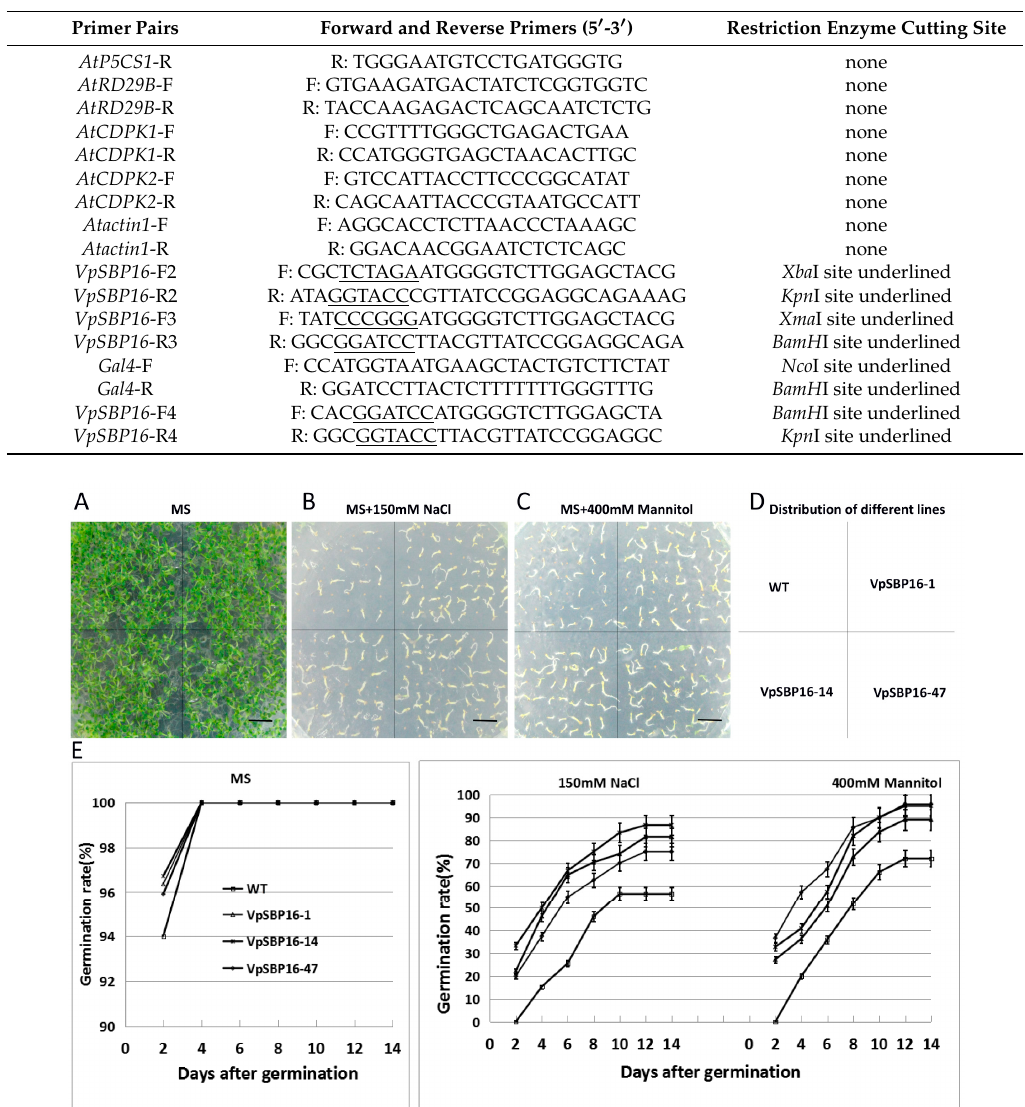
Figure 4. Phenotypes of wild type (WT) and VpSBP16 transgenic Arabidopsis thaliana lines at the